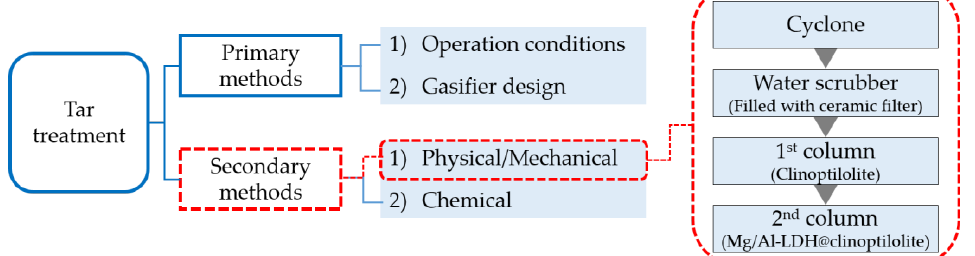
Figure 1. Schematic illustration of the different methods used for tar treatment. The processes marked in red are applicable to this study and have been targeted for improvement.